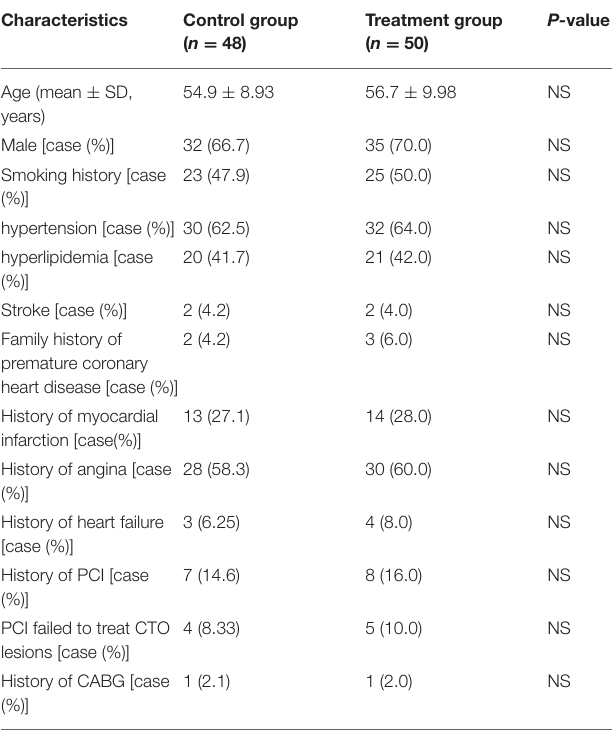
TABLE 1 | Comparison of baseline characteristics between the two groups.